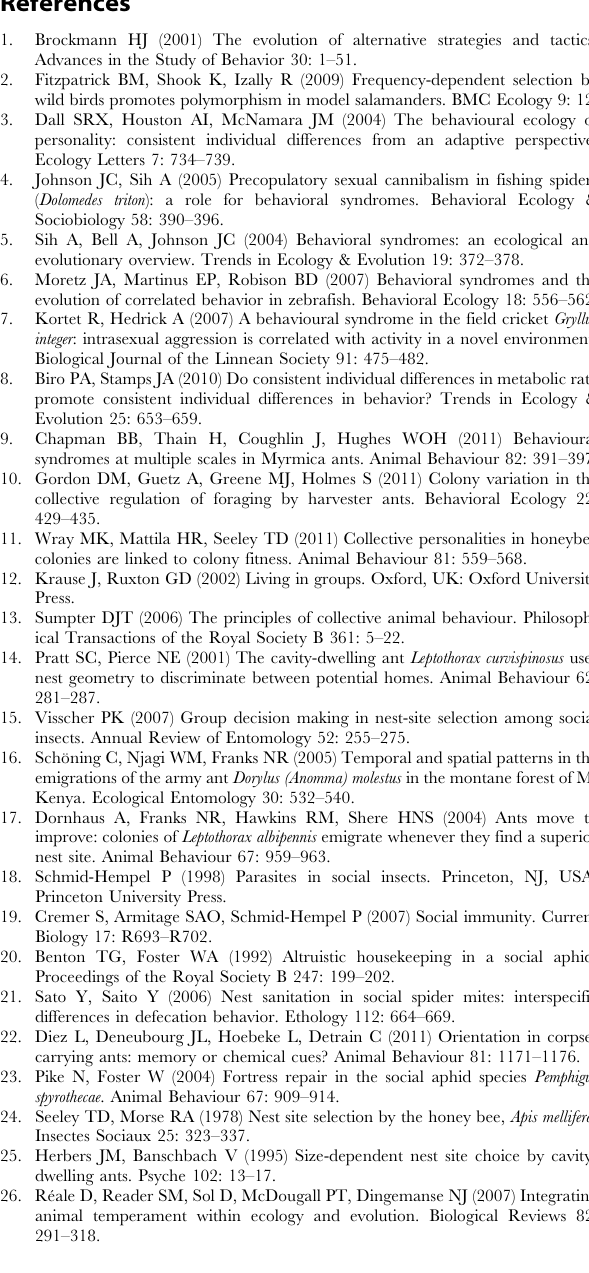
Table S1 Raw dataset used for the statistical analysis. For further information, please contact the first or second author.